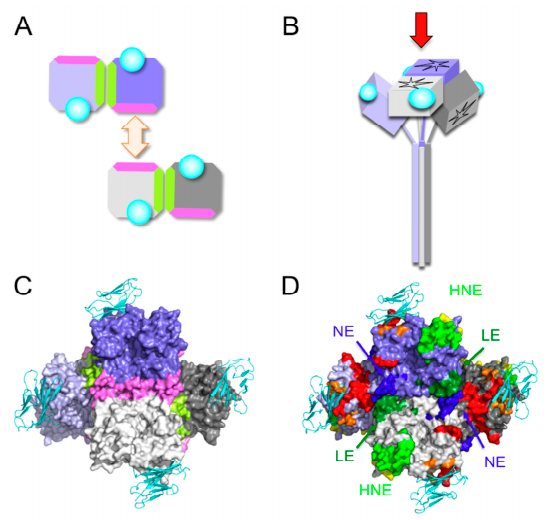
Figure 4. Tetrameric structure of MV-H (form I). ( A – D ) Four H protein molecules are shown in gray, light gray, purple, and light purple. SLAM is shown in cyan. ( A ) Schematic diagram of the formation of the dimer of dimers. Light green regions indicate the interface between the monomers in the dimer. Pink regions indicate the interface between dimers in the dimer of dimers. Pink regions of the purple and light gray MV-H molecules form the interface, whereas those of the gray and light purple MV-H molecules are exposed outside the dimer of dimers (tetramer). ( B ) Schematic diagram of the dimer of dimers (form I). Red arrow indicates the direction of sight for C and D. ( C , D ) Surface presentation models show MV-H, and ribbon diagrams show SLAM. ( C ) Light green regions indicate the interface between the monomers forming the dimer. Pink regions indicate the interface between the dimers forming the dimer of dimers. ( D ) Same angle as C . Amino acids demonstrated or suggested to constitute a portion of an epitope are shown in colors: residues on β -sheets 1, 2, 3, 4, 5, and 6 are shown in blue, red, orange, yellow, light green, and green, respectively.